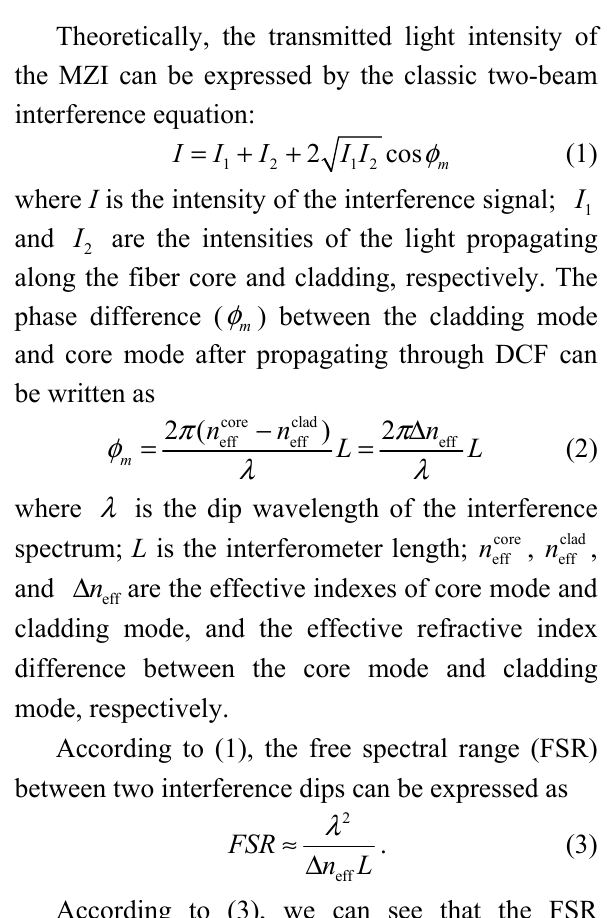
Fig. 2 Output patterns of different fiber splicing structures: (a) SMF, (b) SMF-MMF, (c) SMF-MMF-DCF, and (d)